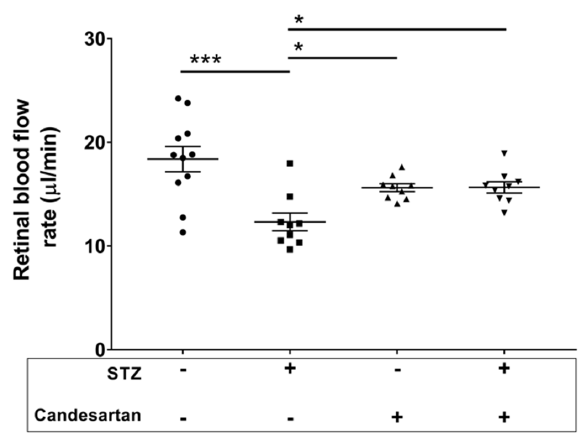
Figure 1. Retinal blood flow rates in the four groups of rats: untreated non-diabetic controls, untreated STZ, candesartan-treated non-diabetic controls, and candesartan-treated STZ. Candesartan treatment in the STZ rats was able to attenuate the STZ-induced decrease in retinal blood flow rate.